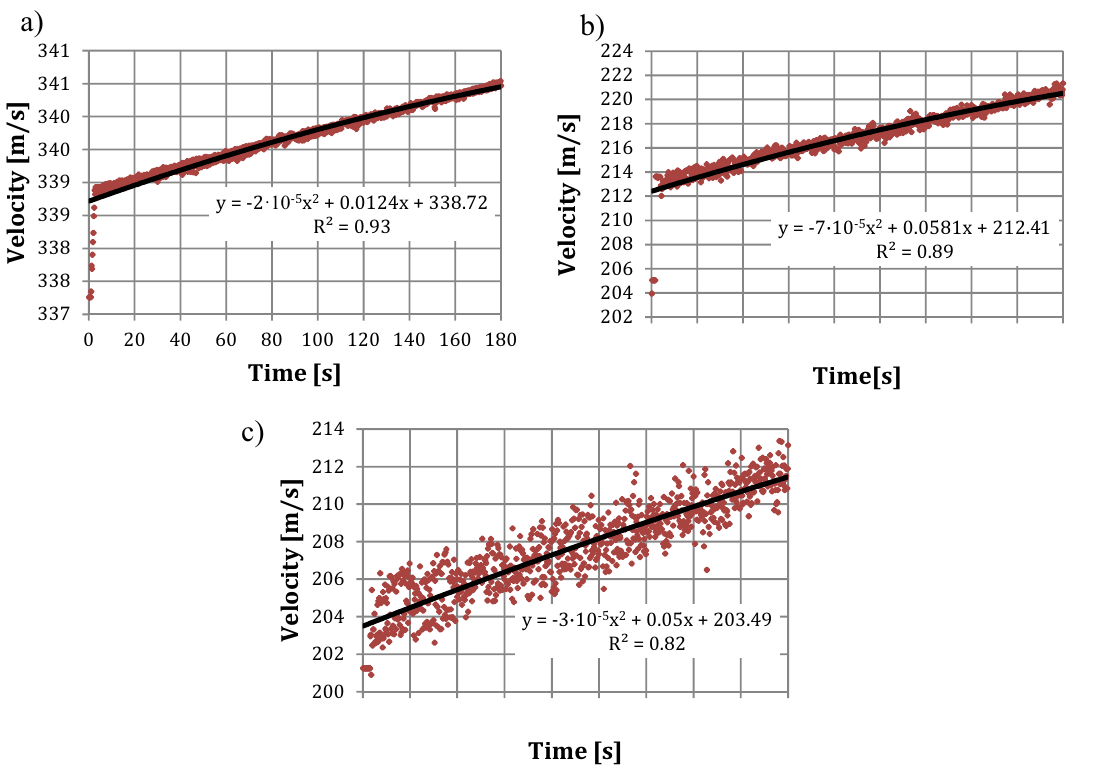
Figure 12. The velocity changes of the water stream for a given distance from the outlet of the nozzle depending on the time: ( a ) at the outlet of the nozzle; ( b ) for a distance of 0.05 m from the inlet of the nozzle; ( c ) for a distance of 0.10 m from the inlet of the